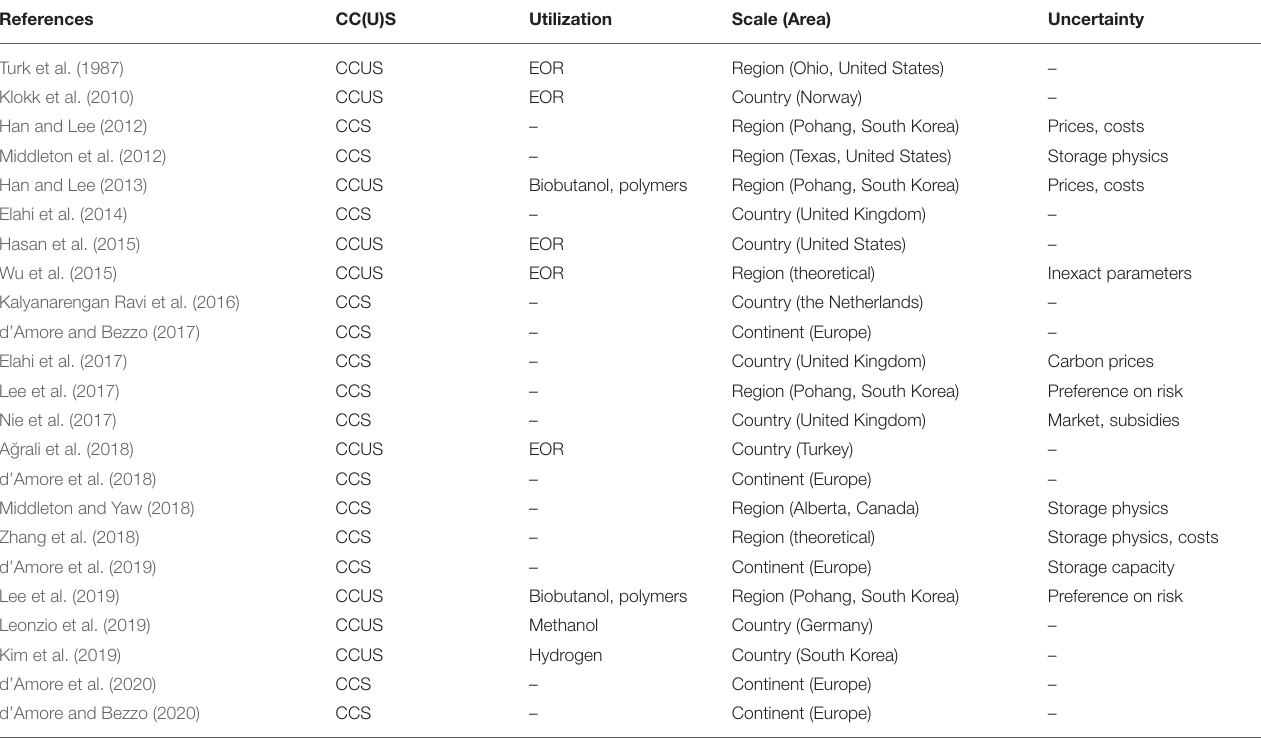
TABLE 1 | Literature review on published contributions on SC optimization for